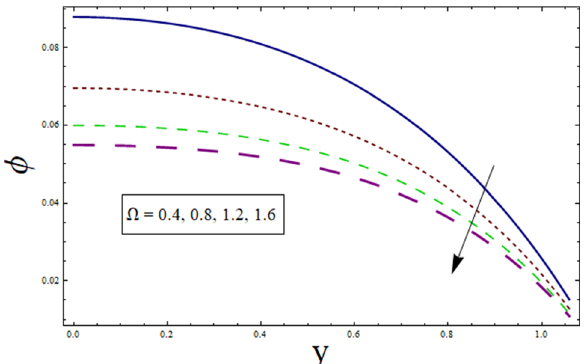
Figure 29. ϕ for (cid:31)